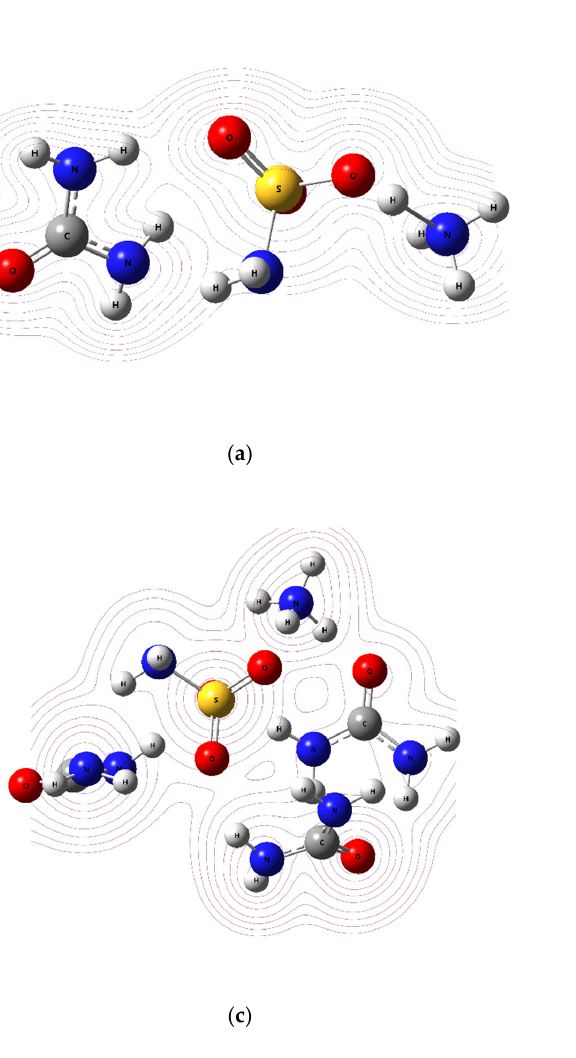
Figure 8. MEP contour maps for ( a ) ASA–urea1, ( b ) ASA–urea2, ( c ) ASA–urea3, and ( d )